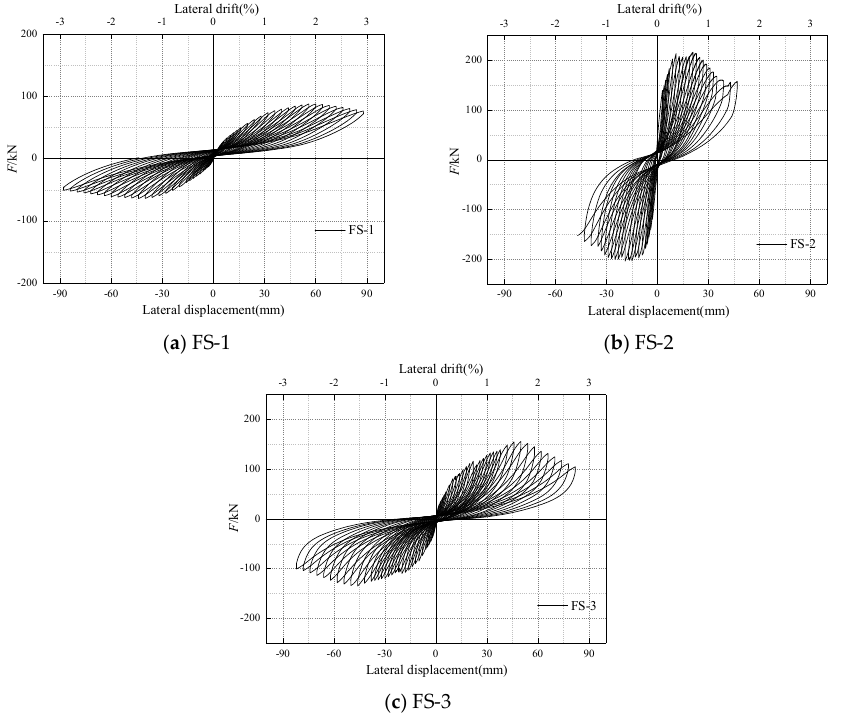
Figure 9. Hysteresis curves.